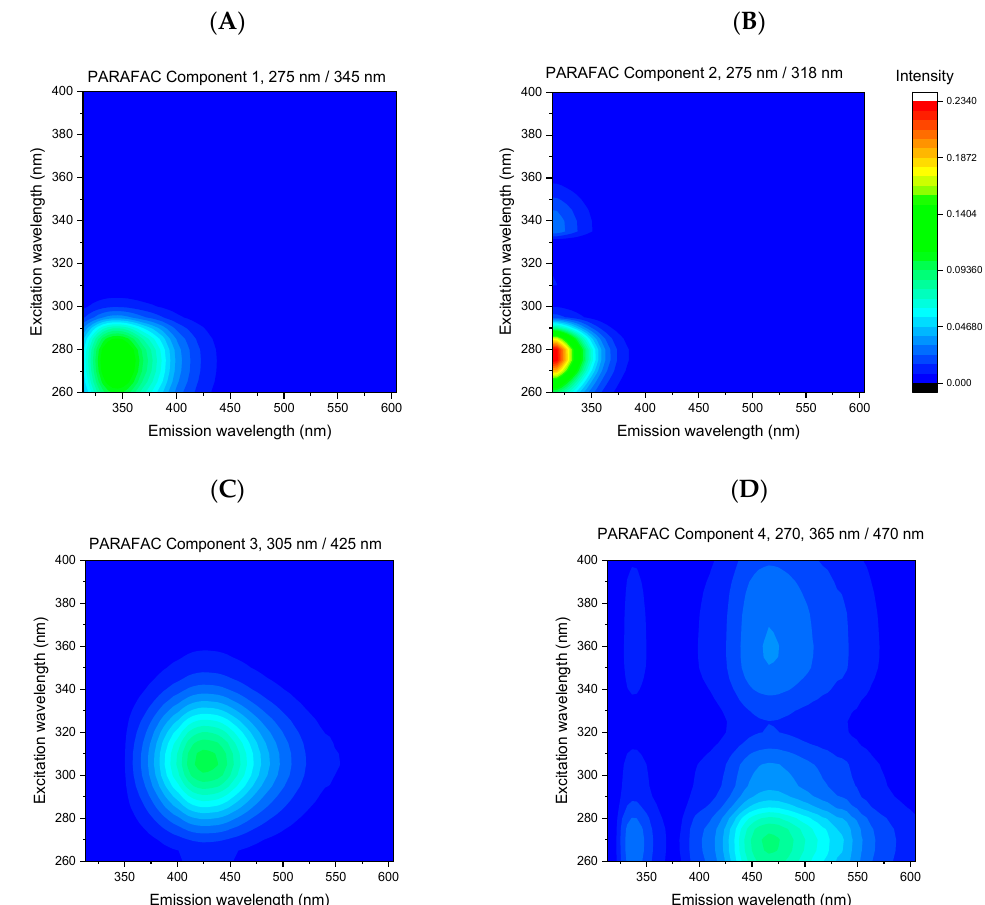
Figure 3. The contour maps of EEMs of fluorescent components obtained as a result of PARAFAC of EEMs of direct fresh juices and processed commercial strawberry beverages: ( A ) component 1, ( B ) component 2, ( C ) component 3, ( D ) component 4.